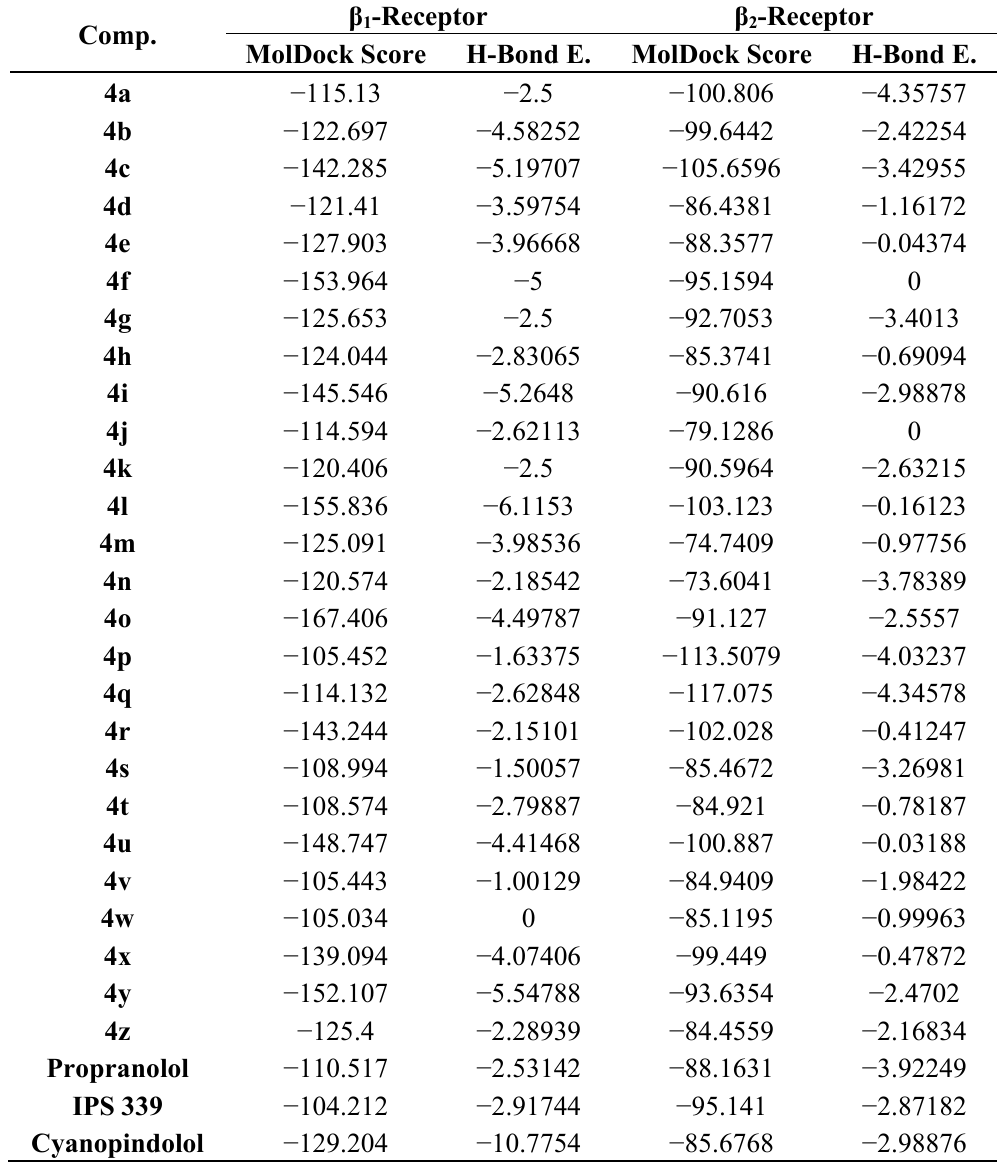
Table 3. MolDock scores and hydrogen bond energy for compounds 4a – z and reference compounds with the β β 1 and 2